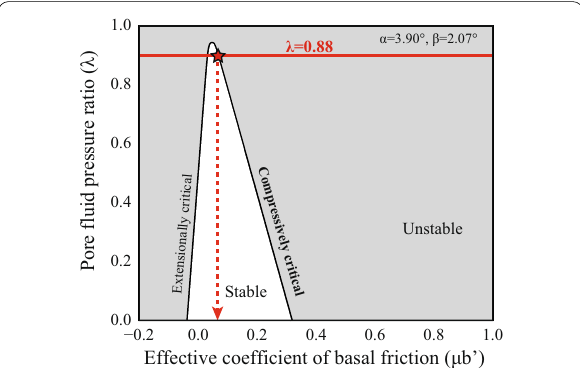
Fig. 2 Cross plot between the pore fluid pressure ratio λ and basal friction μ b ’ in the wedge. All extensionally critical states form the left limb of the critical state curve, and all compressively critical states form the right limb. The stable region is under the curve (white). The straight‑line intersecting the critical state curve represents constant